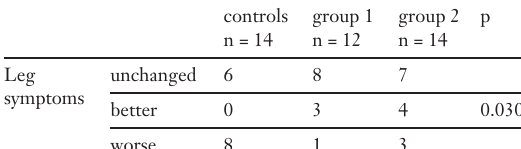
Leg symptoms compliance (one week